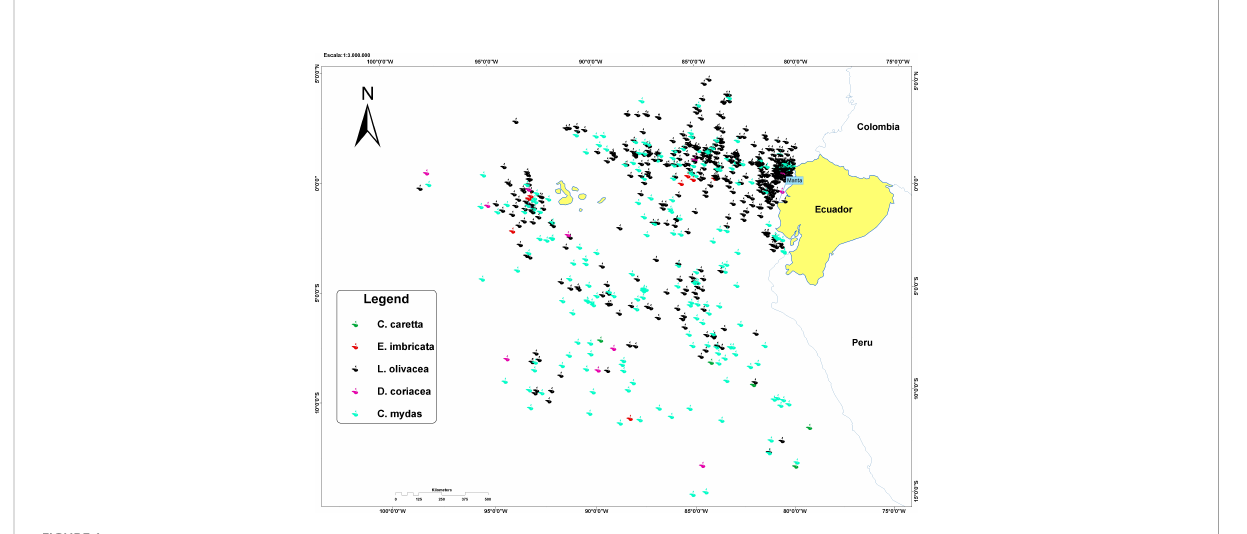
FIGURE 1 Location of sea turtles captured incidentally on